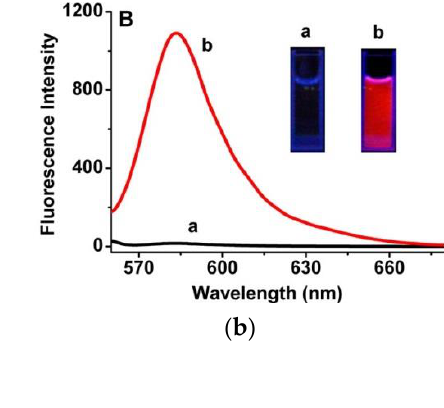
Figure 6. ( a ) Structure of probe NBP; ( b ) In the confocal imaging of A459 cells at different oxygen concentrations. Reproduced with permission from [58]. Copyright 2013 The Royal Society of Chemistry.